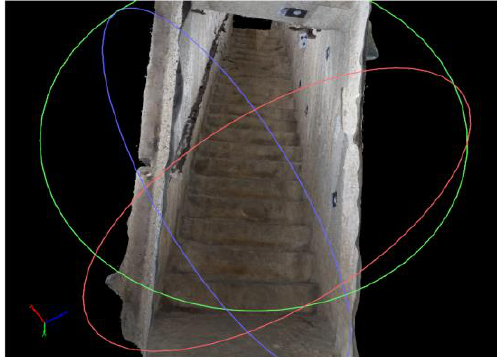
Figure 14: Result of 3D reconstruction for the top of the dome and